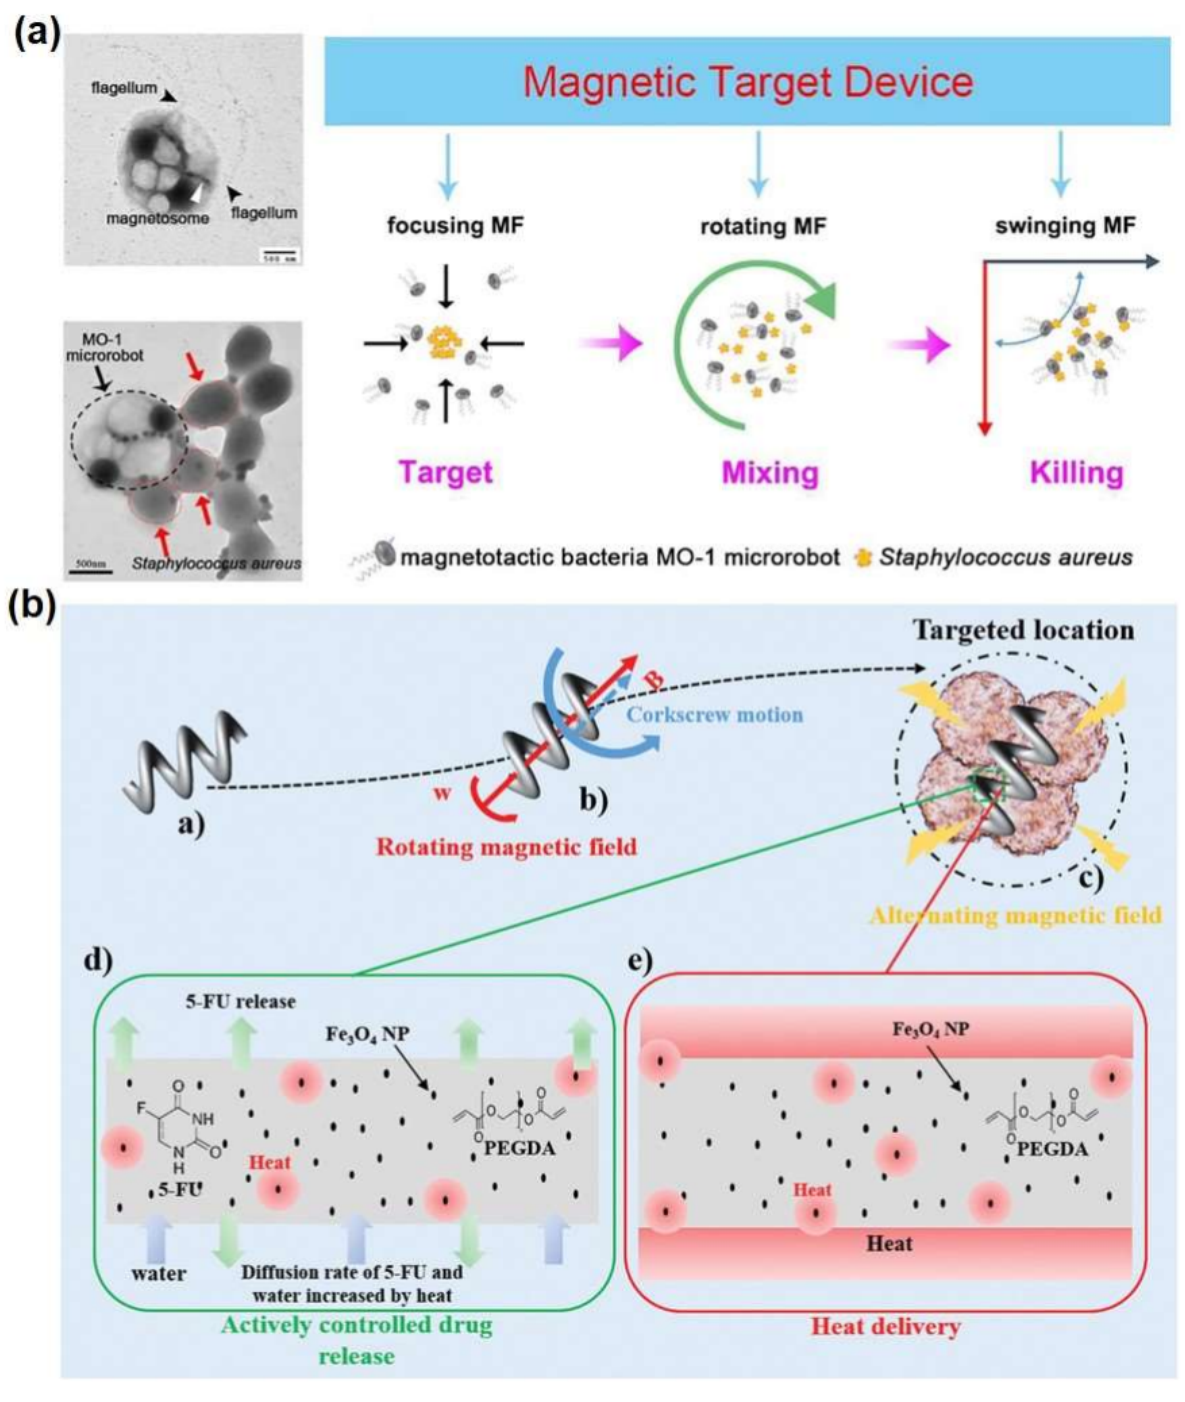
Figure 5. Examples of the application of micro/nanorobots as surgery tools in disease